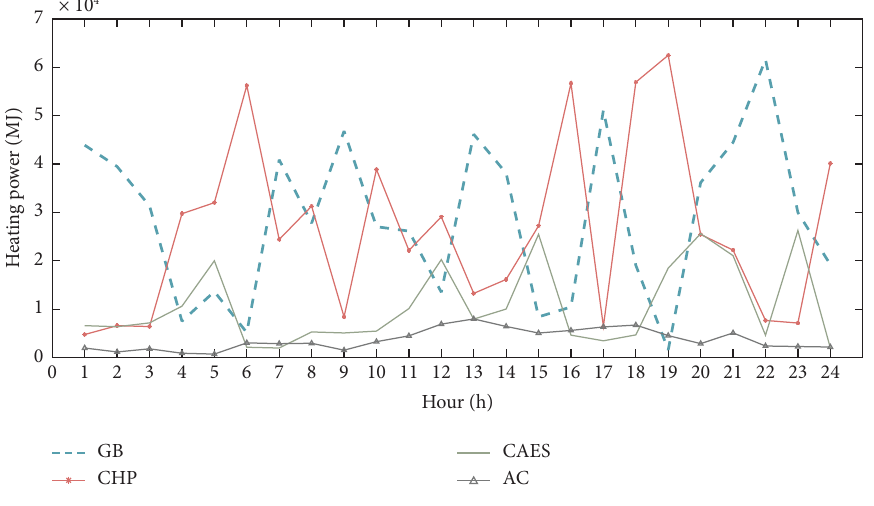
Figure 11: Heating energy dispatch in summer.